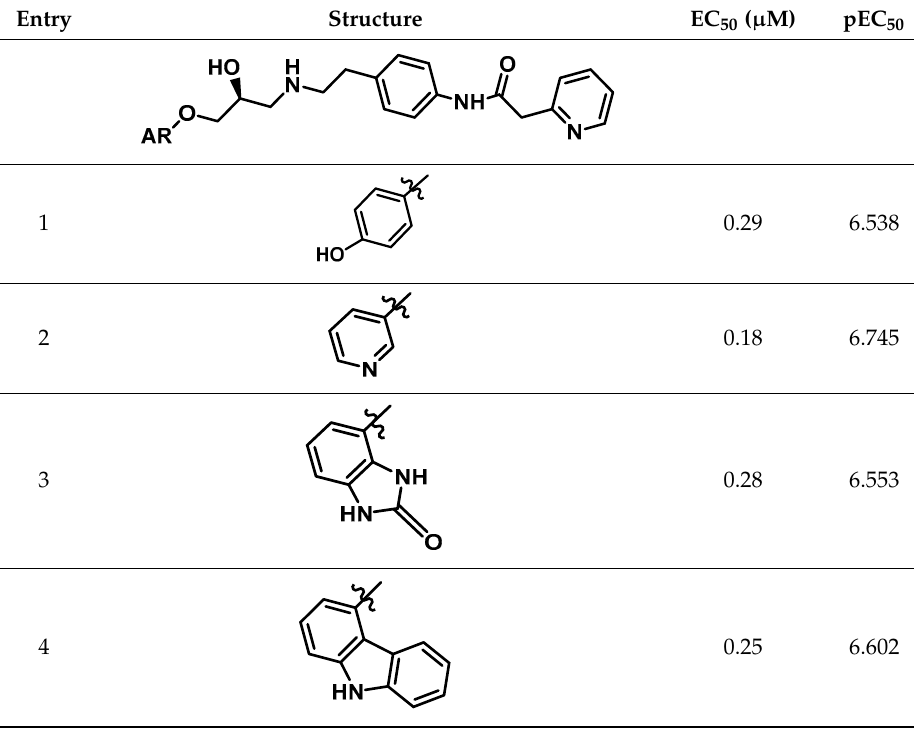
Figure 6. Histogram of frequency distribution data. Table 6. Chemical structures and pEC 50 values of the studied β 3-adrenergic ligands a .